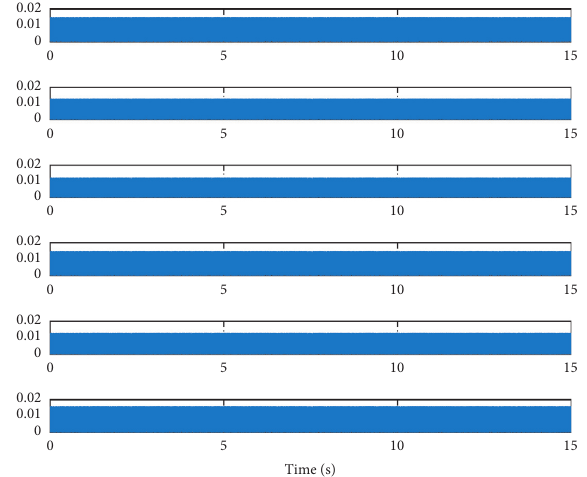
Figure 8: Measurement noises for joint positions q